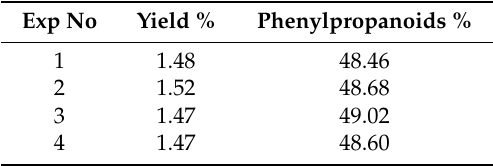
Table 3. Recycling experiments using ionic liquid 5 0.5